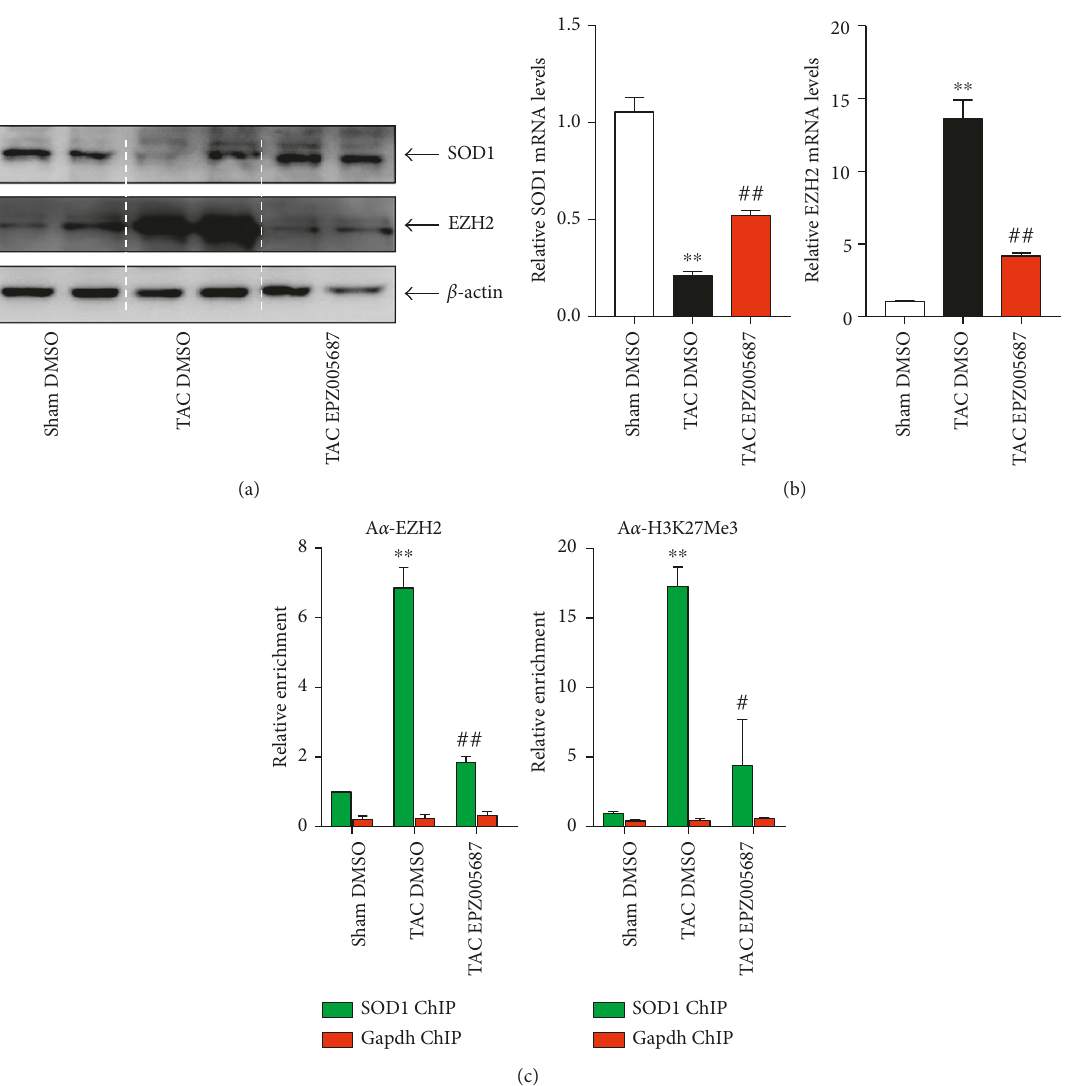
Figure 4: EZH2 regulates TAC-induced PAH by targeting SOD1. Expression levels of SOD1 and EZH2 were measured by (a) Western blot and (b) qPCR ( n � 5 for each group, ∗∗ P < 0 . 001 versus sham control, ## P < 0 . 001 versus TAC DMSO). (c) ChIP assays were performed with anti-EZH2 and anti-H3K27Me3 using lung tissues in indicated mice ( n � 5 for each group, ∗∗ P < 0 . 001 versus sham control, ## P < 0 . 001, # p < 0 . 01 versus TAC